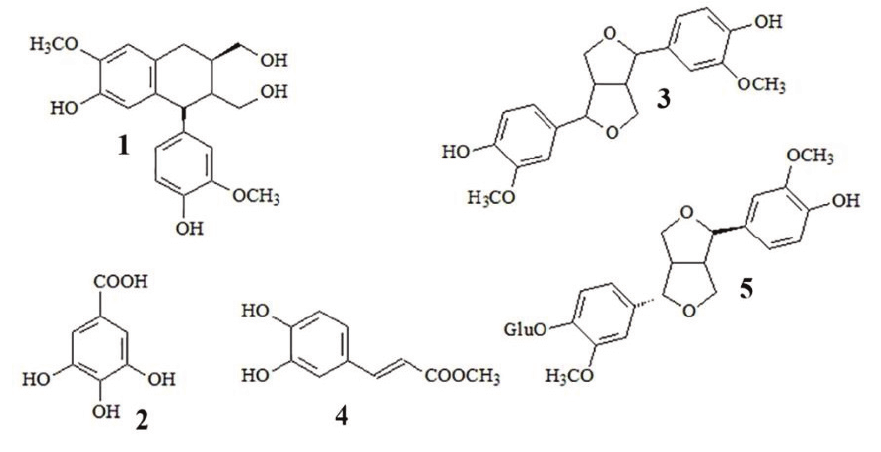
Fig. 4. Isolated compounds from the whole plant of Balanophora fungosa var. globosa : 1 – isolariciresinol, 2 – gallic acid, 3 – pinoresinol, 4 – methyl caffeate, 5 – epipinoresinol­4­ O